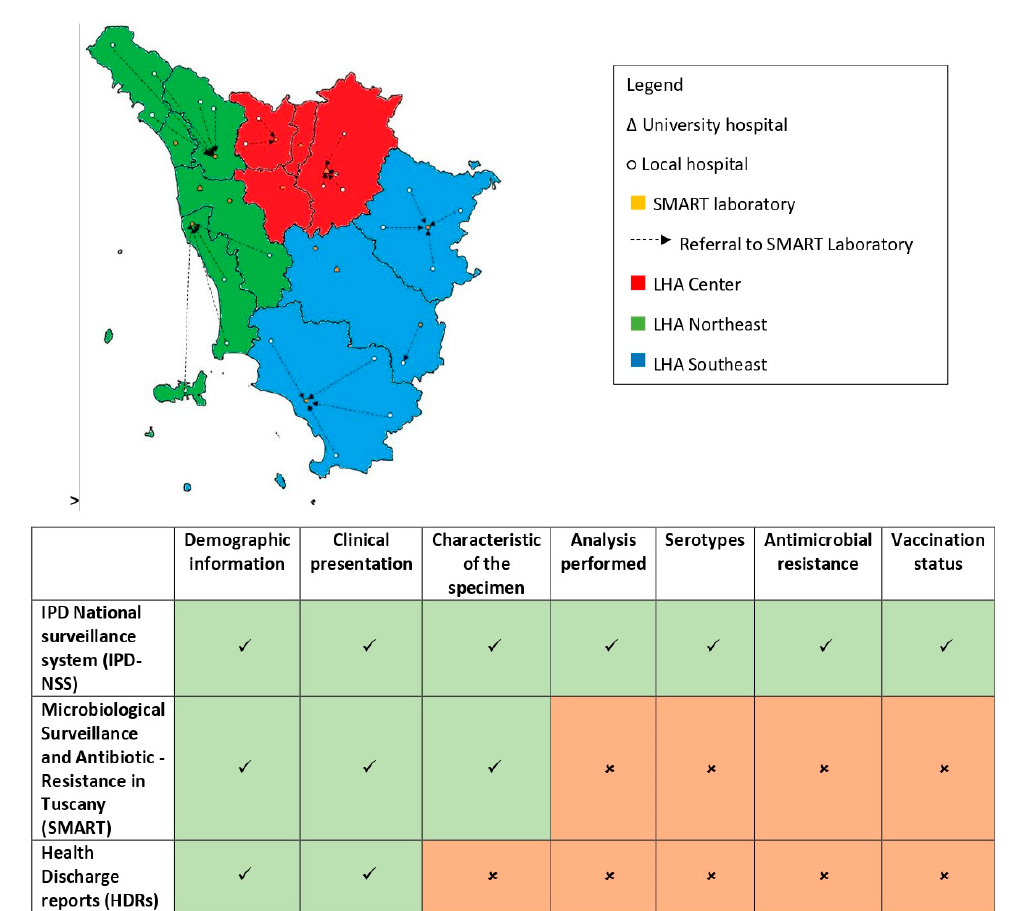
Figure 1. The Tuscany invasive pneumococcal disease data sources. Different data sources can be used to estimate invasive pneumococcal disease (IPD) burden in Tuscany. All doctors can notify a case to the national IPD Surveillance system, while all laboratories of the microbiological surveillance system SMART (Microbiological Surveillance and Antibiotic Resistance in Tuscany) collect specimens from all hospitals and communicate positive results to the regional health authority (ARS, Agenzia Regionale di Sanità Toscana). Hospital discharge records are also collected by the ARS and accessible for research. Different features of IPD are covered by different data sources.